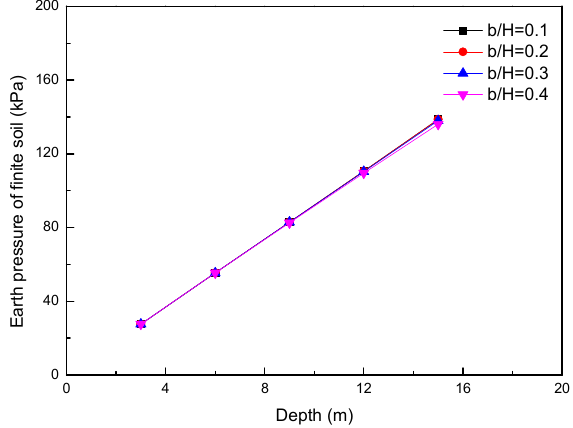
Figure 11. Influence of width-to-depth ratio on earth pressure of finite soil.